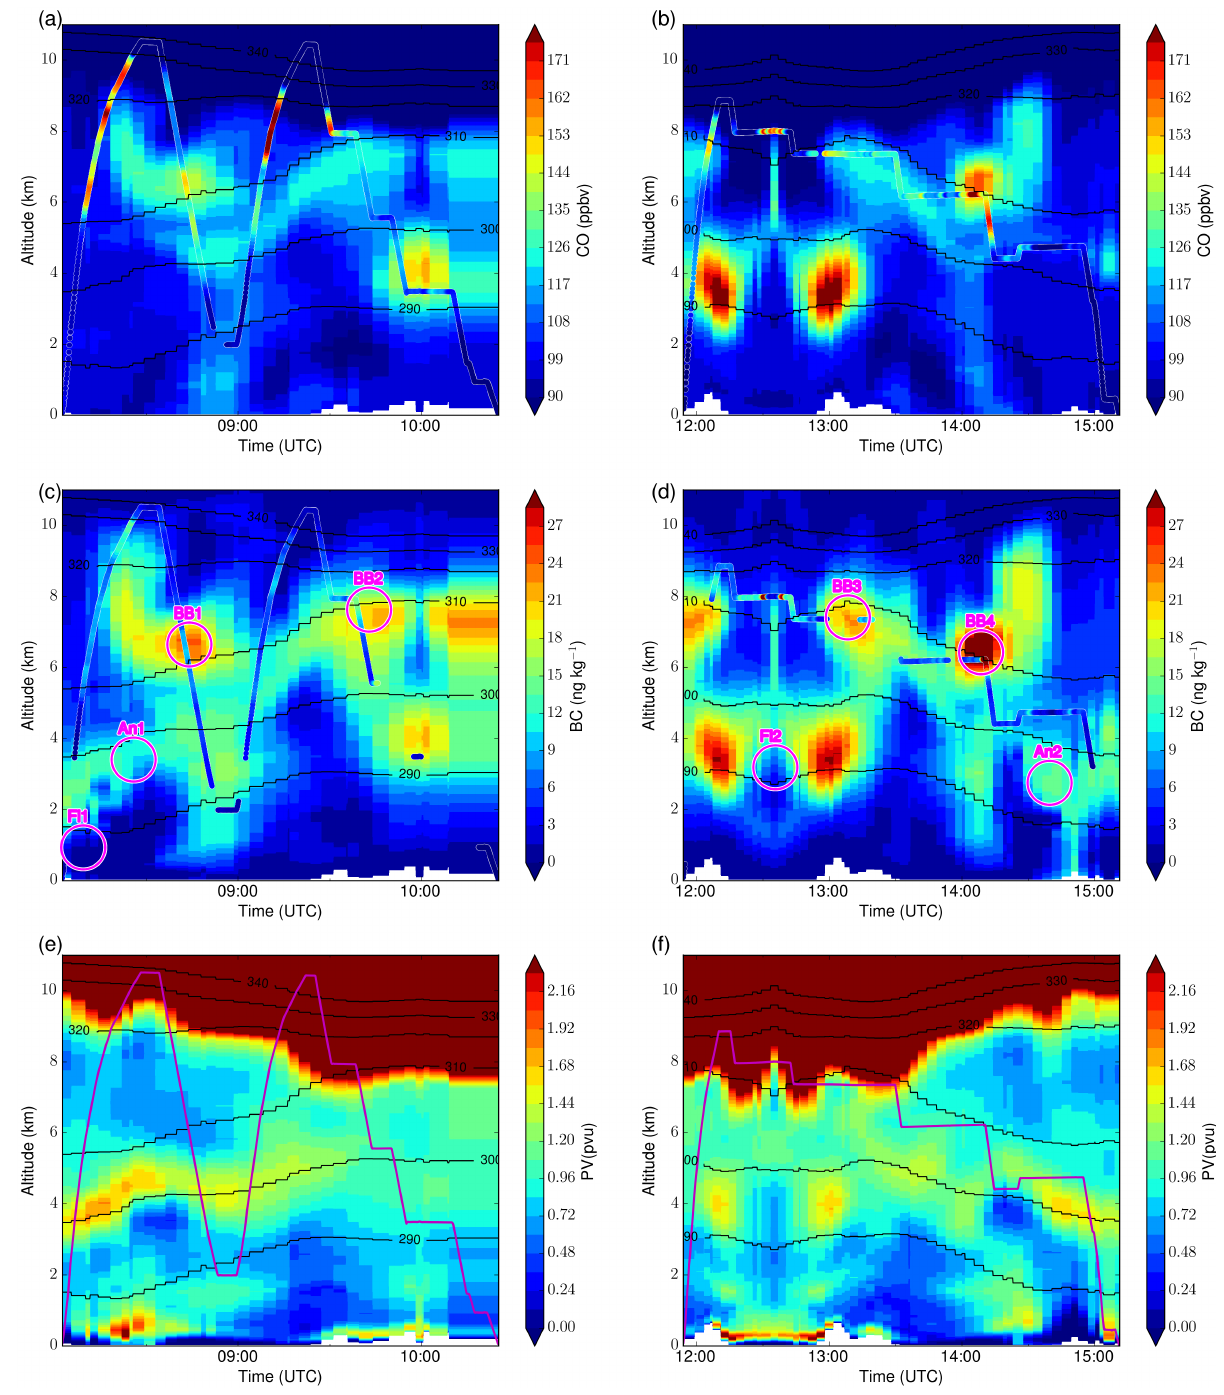
Figure 8. Vertical cross sections of (a, b) CO mixing ratio, (c, d) BC mixing ratio, and (e, f) PV along Falcon flight tracks on 17 July 2012 extracted from WRF-Chem between the island of Andøya and the Svalbard archipelago. In situ measurements aboard the Falcon averaged using a 2min running mean are shown in each panel with colored dots, using the same color scale. Only BC values outside of clouds are reported. Black solid lines represent the dry isentropes between 290 and 340K. Magenta circles highlight the air masses discussed in Sect.